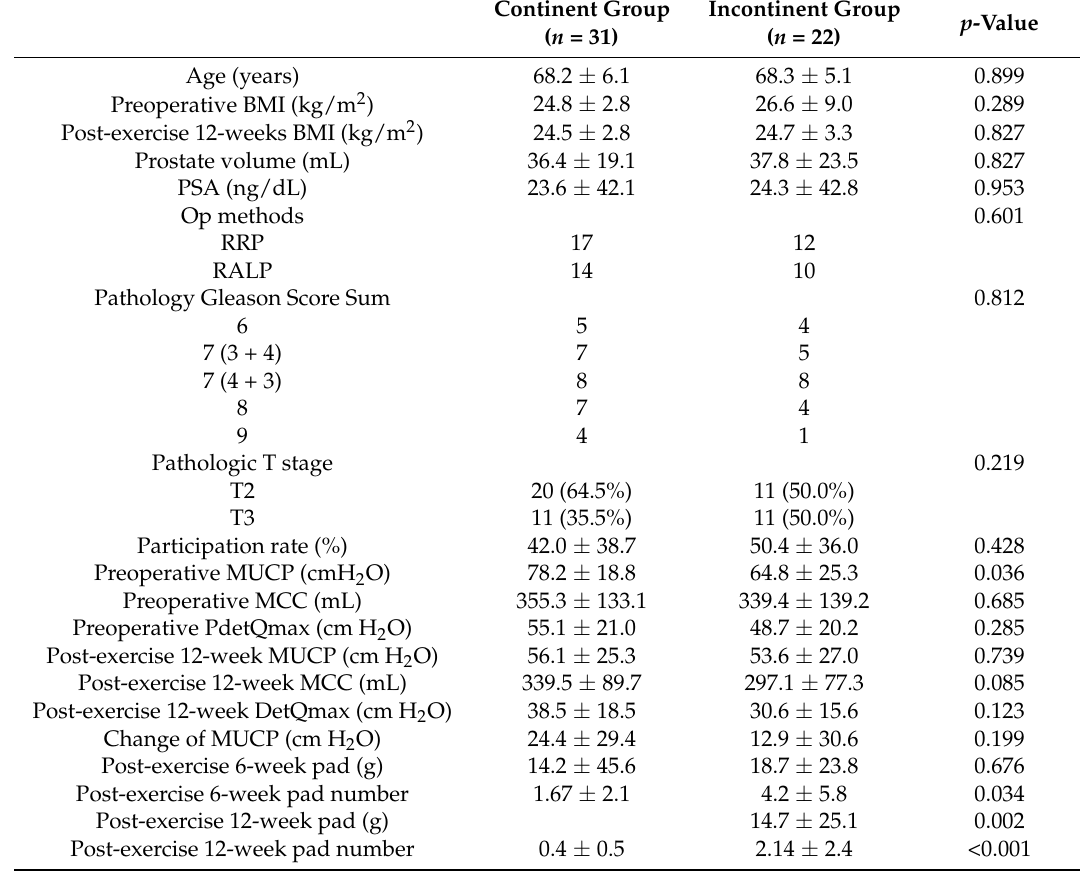
Table 1. Patient characteristics according to the achievement of post-exercise continent